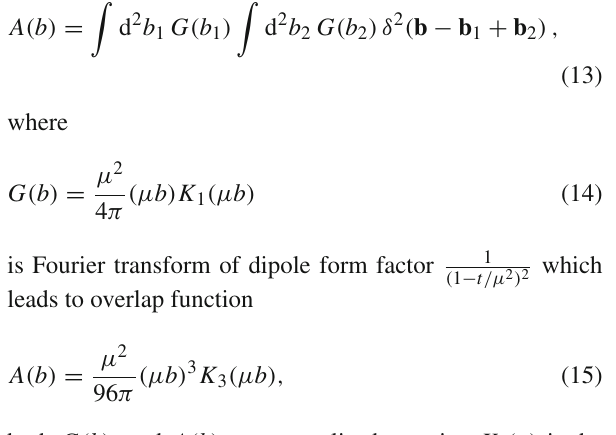
is preferred by the CDF σ eff data [39]. Right panel: an extension of p ⊥ into non-perturbative regime with “Gaussian” transverse momentum distribution for two parameters sets denoted by circles on the plot in the which 0 left